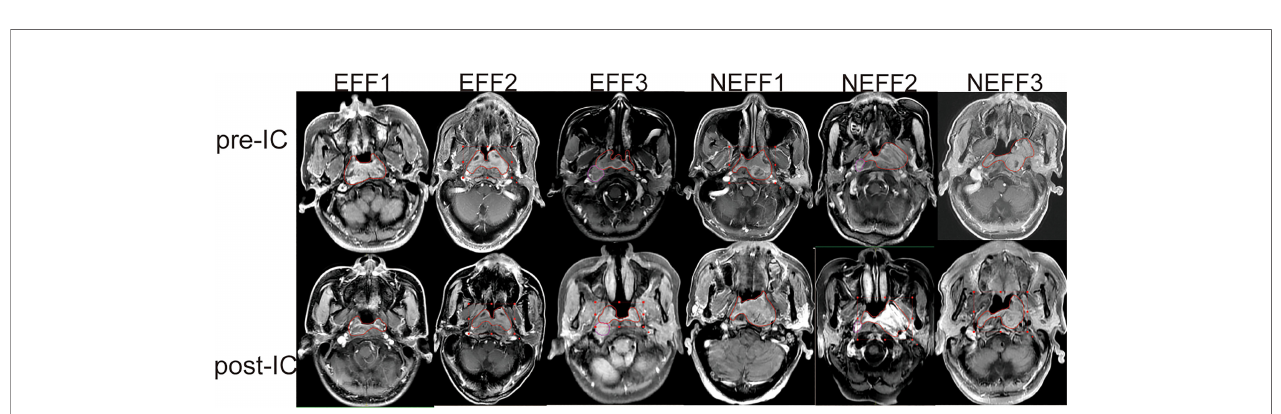
FIGURE 2 | Typical MRI images for GTV changes before and after IC. MRI images of three patients with PR (EFF1-3), one patient with PD (NEFF1), and two patients with SD (NEFF2-3) at baseline (pre-IC) and after two cycles of IC (post-IC). The area within the red line is the primary focus. MRI, magnetic resonance imaging; GTV, gross tumour volume; IC, induction chemotherapy; EFF, effective; NEFF,